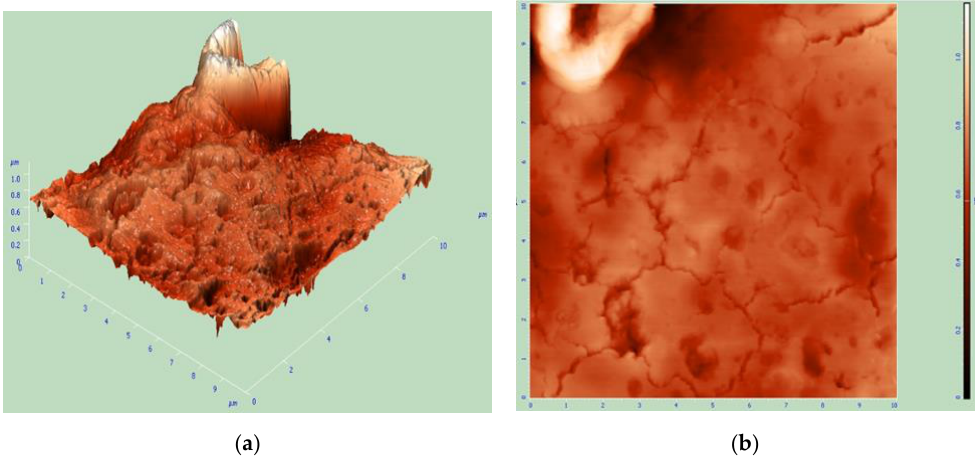
Figure 5. ( a ) 3D topographical atomic force microscopic (AFM) image and ( b ) 2D AFM topographical image of AS-g-PAni@MS nanocomposite.